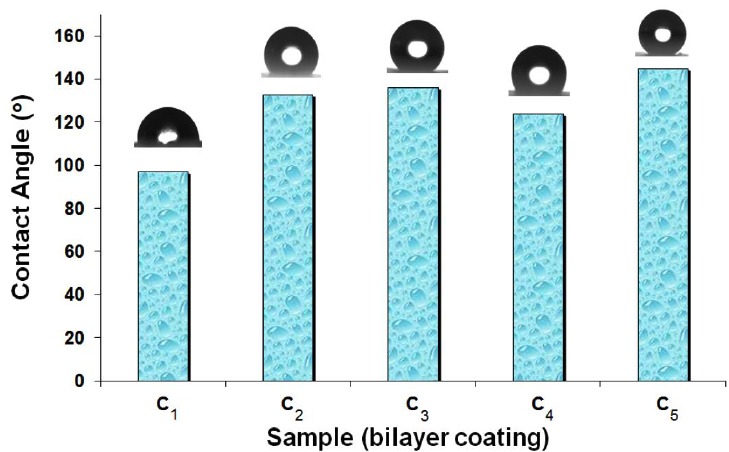
Figure 5. Contact angle of the bilayer coatings (see Table 3).